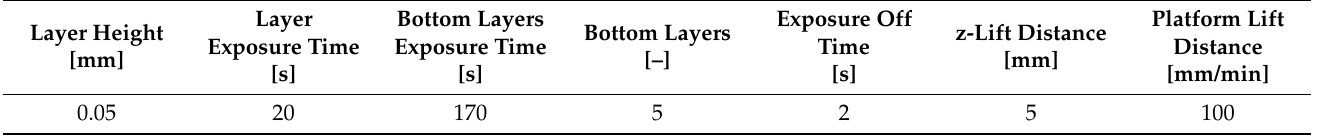
Table 2. SLA printing settings for 3Dresyn Perfect Cast WS1 Water Soluble (3Dresyn, Barcelona, Spain).